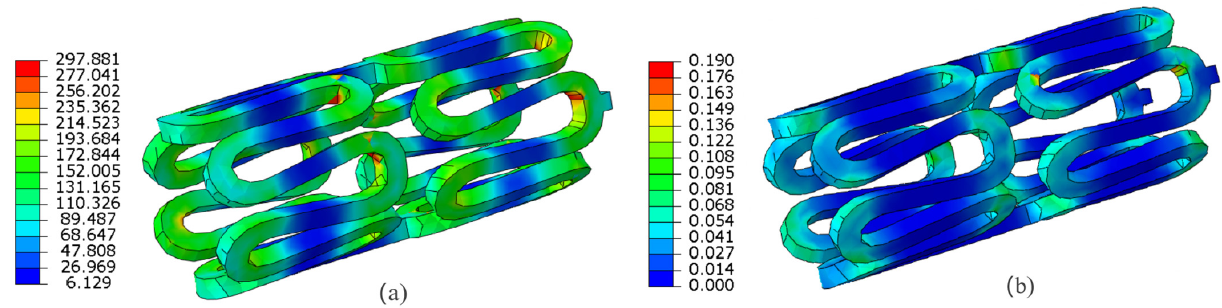
Figure 7. The equivalent stress ( a ) and equivalent strain ( b ) distribution contours for the stent after spring-back.